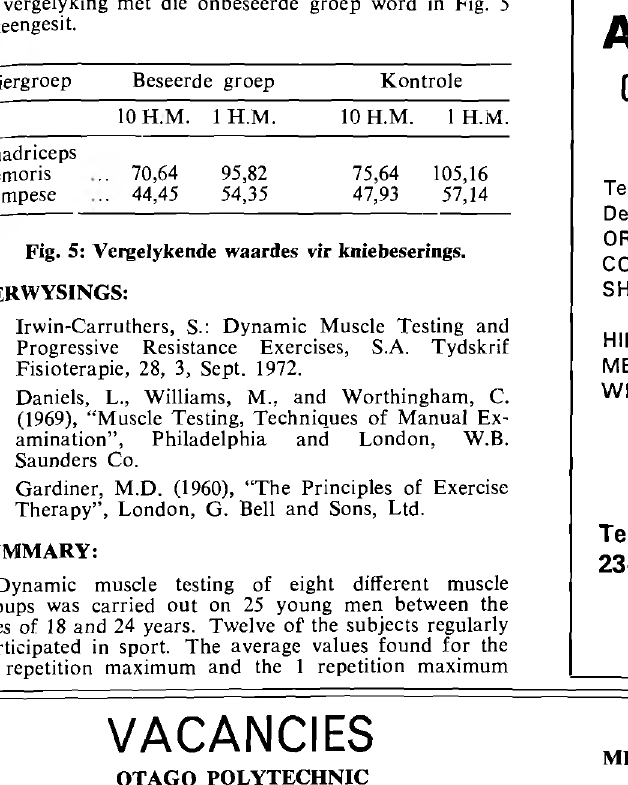
Fig. 5: Vergelykende waardes vir